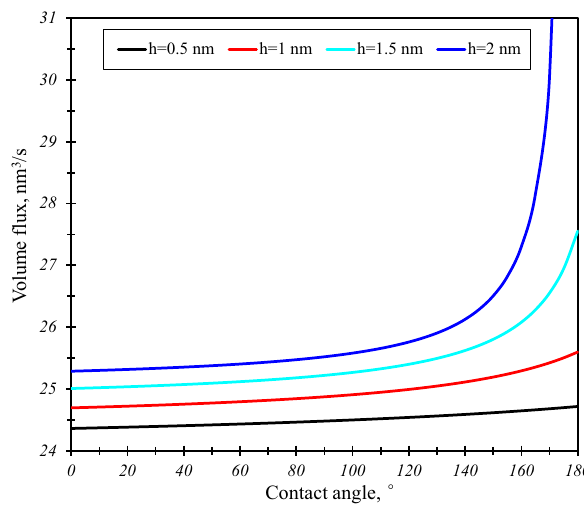
Fig. 3 The relationship between volume flux and contact angle under different critical thickness